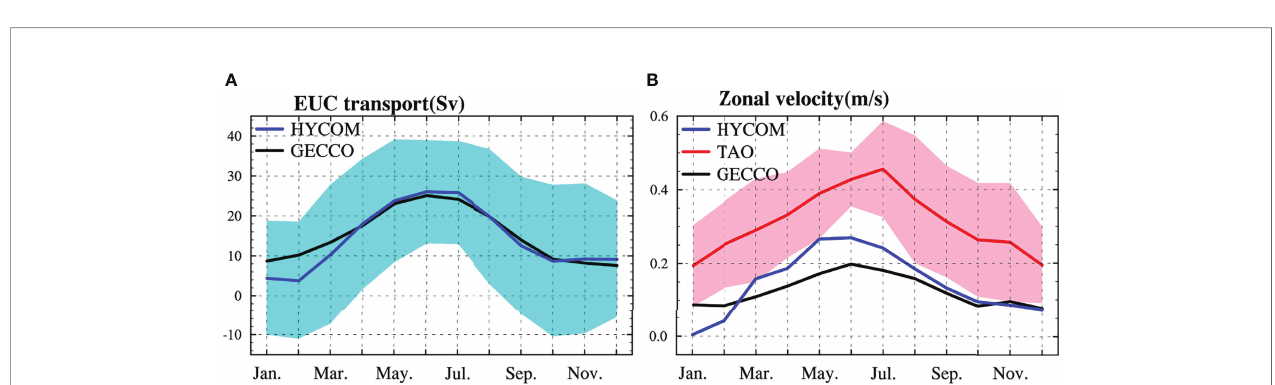
FIGURE 2 | (A) The annual cycle of EUCT (Sv) from GECCO and HYCOM, in which the blue shading marks the standard deviations of EUCT from HYCOM. Note that the EUCT from HYCOM is calculated in the area 3°S – 3°N, 85 m – 310 m. (B) The zonal velocity (m s -1 ) at (165°E, 0°N) averaged in 100 – 300 m from TAO/ TRITON observation, HYCOM, and GECCO, in which the pink shading marks the standard deviations of zonal velocity from TAO/TRITON observation. Note that the climatological zonal velocities of HYCOM and TAO/TRITON are averaged between 1994 and